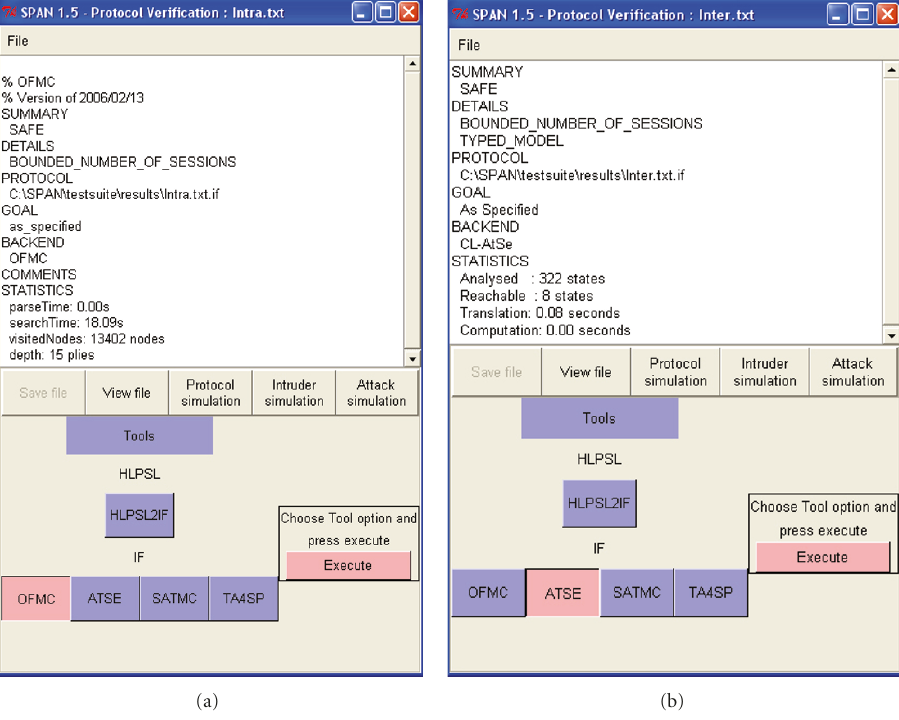
Figure 15: (a) Message returned by SPAN as a result of testing Intra-WLAN FP with OFMC. (b) Message returned by SPAN as a result of testing Inter-WLAN FP with Cl-AtSe.